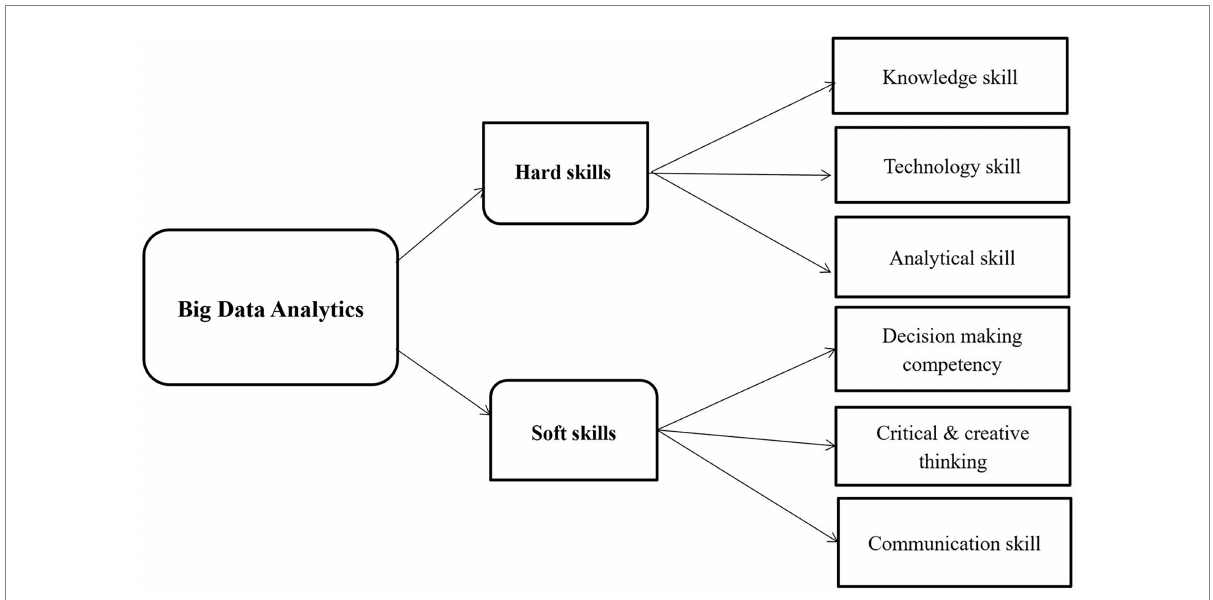
FIGURE 3 Educational dimensions of the big data analytics course.